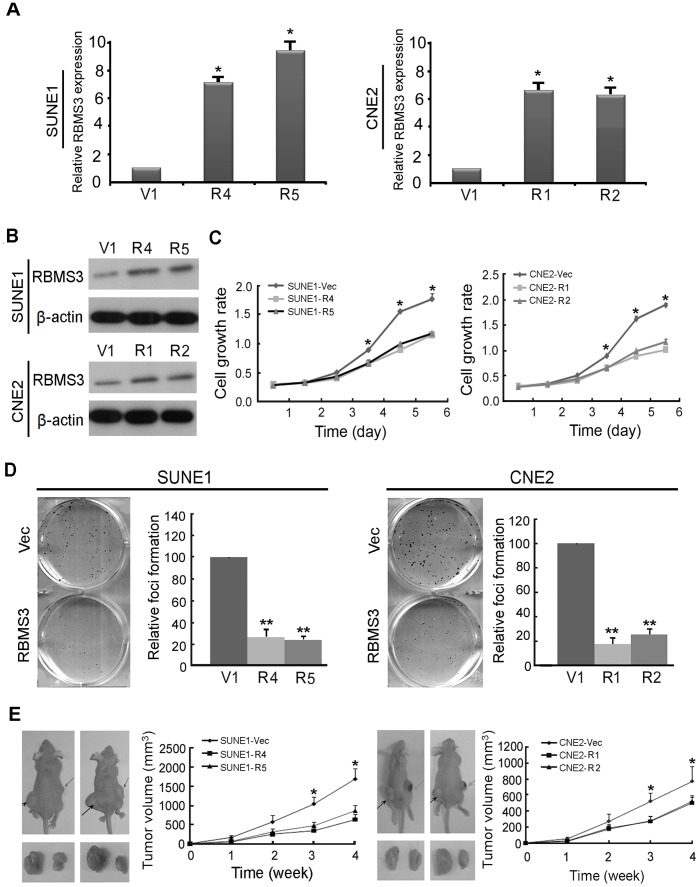
Tumor suppressor function of RBMS3 in NPC cells.Expression of RBMS3 in RBMS3-transfected SUNE1 (SUNE1-R4 and R5) and CNE2 cells (CNE2-R1 and R2) was confirmed by quantitative PCR (A) and Western blot (B). Empty vector-transfected cells (SUNE1-V1, CNE2-V1) were used as control. (C) An MTT assay was used to compare cell growth rate between RBMS3- and empty vector-transfected NPC cells. The results found that cell growth rate was significantly decreased in RBMS3-transfected SUNE1 and CNE2 cells (* p<0.05; ** p<0.001, Student’s t-test). Values were expressed as mean ± SD of three independent experiments. (D) Foci formation assay showed that the number of foci was significantly decreased in RBMS3-transfected SUNE1 and CNE2 cells compared to the control cells, respectively (** p<0.001, Student’s t-test). The results were expressed as mean ± SD of three independent experiments. (E) Representatives of tumor formation in nude mice. Tumors induced by SUNE1-V1 (left) and SUEN1-RBMS3 (right) were indicated by arrows, respectively. Excised tumors were shown in the bottom. Summary of tumor growth rates in nude mice induced by RBMS3- and empty vector-transfected NPC cells. The average tumor volume was expressed as mean ± SD in 10 inoculated sites for each group (* p<0.05).